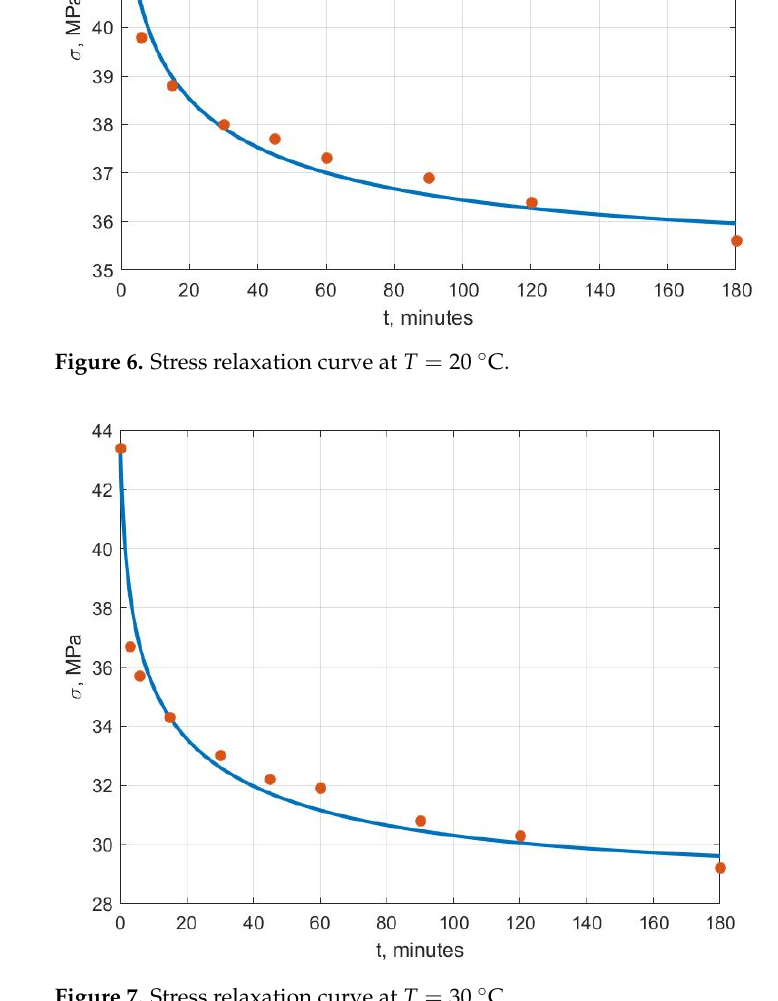
Figure 8. Stress relaxation curve at 𝑇 = 40 °C .